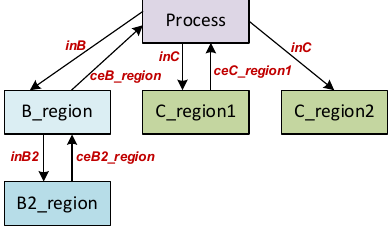
Figure 9. The CFSM model.